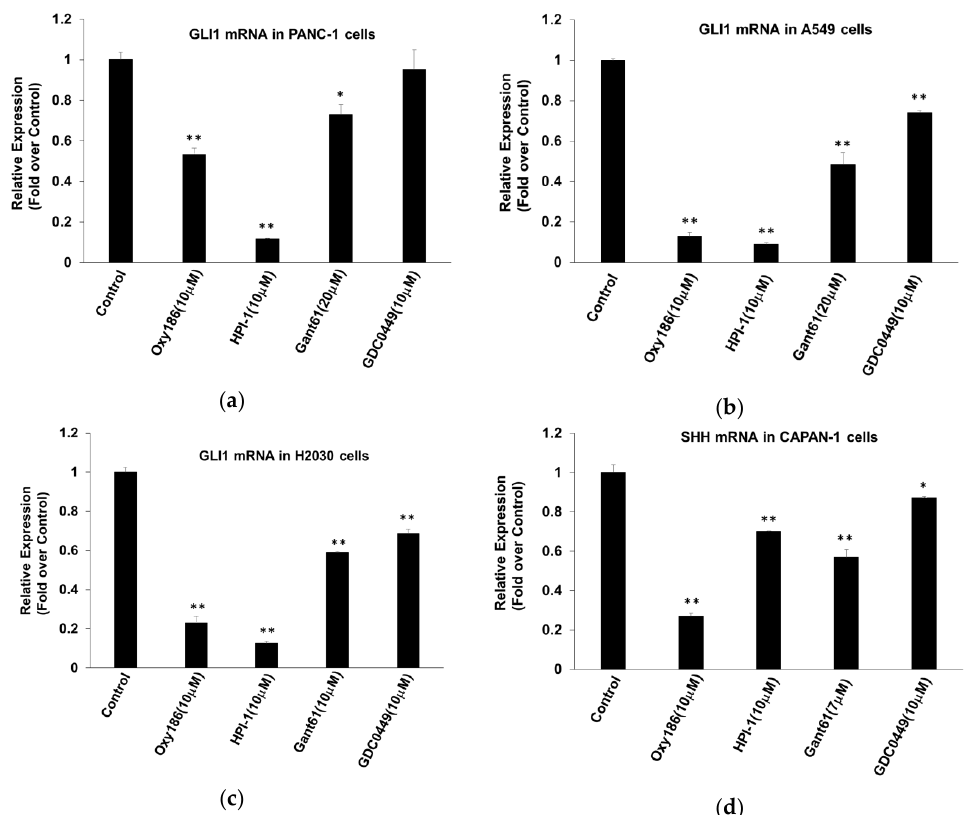
Figure 4. Inhibition of Gli and Shh expression in ( a ) PDAC (PANC-1) and ( b , c ) human lung cancer cells (A549 and H2030, respectively) by Oxy186. Cells were treated with the compounds as indicated in DMEM or RPMI 1640 containing 5% FBS for ( a ) 48 or ( b , c ) 72 hours, then RNA was extracted and analyzed by Q-RT-PCR for the expression of Gli1 and normalized to GAPDH expression. ( d ) CAPAN-1 cells were treated with the compounds, as indicated, in DMEM containing 5% FBS for 72 h, then RNA was extracted and analyzed by Q-RT-PCR for the expression of Shh and normalized to GAPDH expression. Data from a representative experiment are reported as the mean of triplicate determinations ± SD (* p < 0.05 vs. control; ** p < 0.01 vs. control). Tumor cells have been shown to secrete Hh ligands that may stimulate tumor stromal cells to produce various factors that facilitate growth and metastasis of the tumor cells [7,42]. This type of paracrine Hh signaling emanating from tumor cells is believed to play an important role in tumor